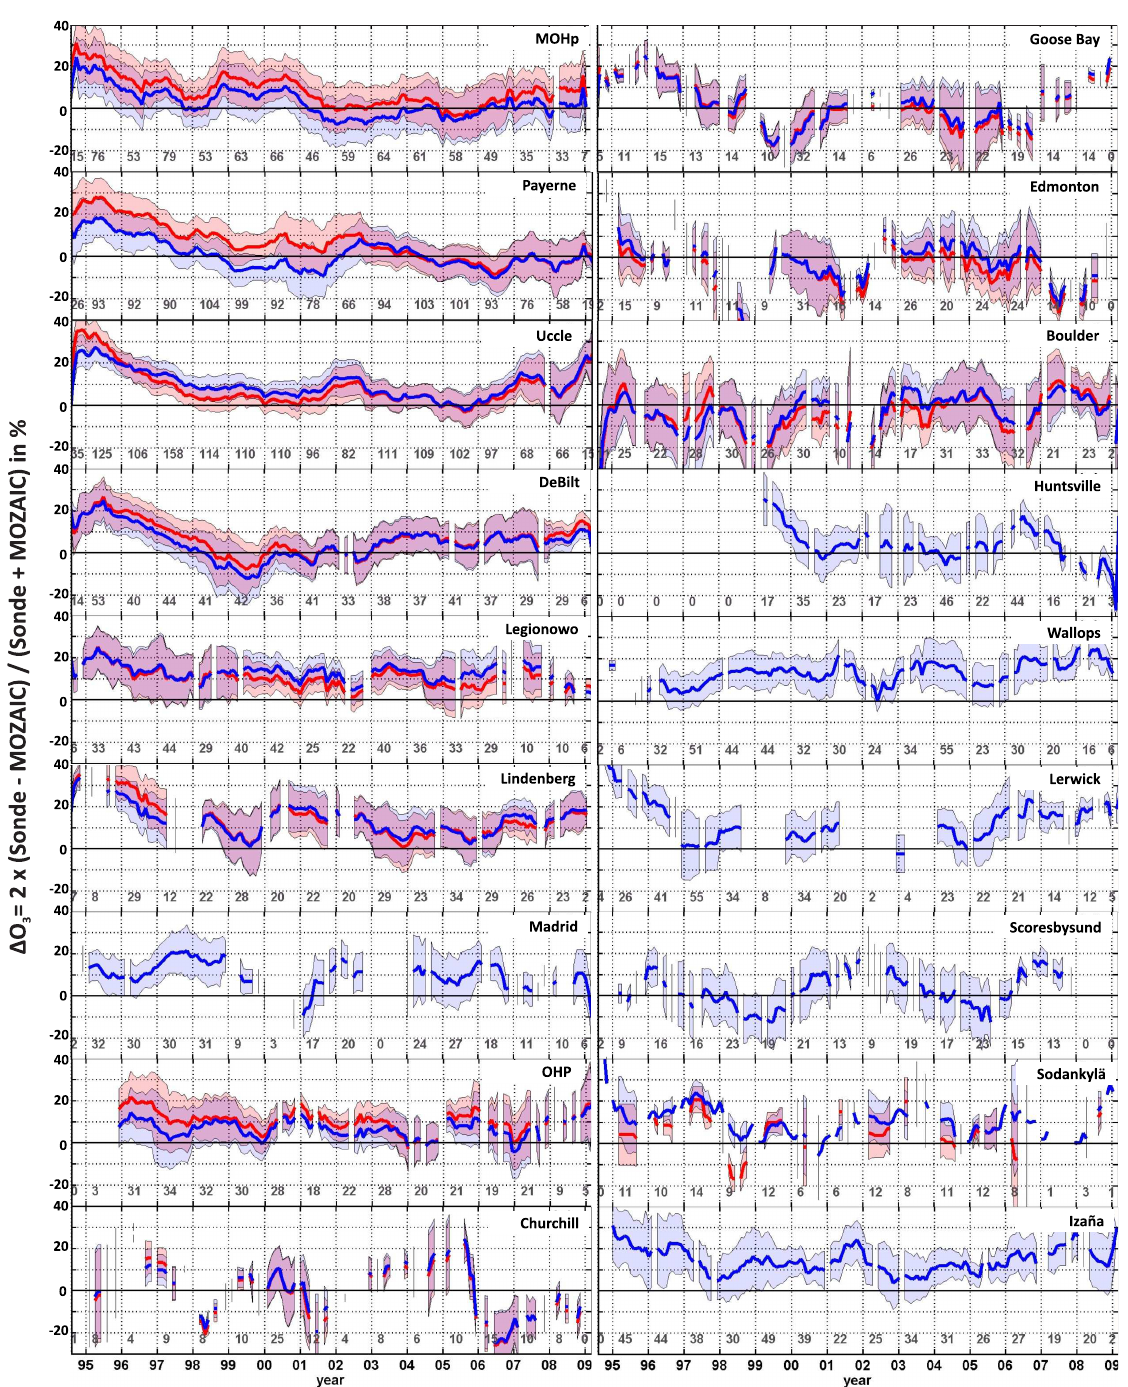
53 Fig. 16. Time series of the relative differences between ozonesondes and MOZAIC measurements ( 1 O 3 in %) in the upper troposphere. These time series comprise 20 of the 28 launch sites considered in this work (the 8 remaining have too few matches with MOZAIC to be included here). Note the large differences at nearly all sites from 1994 to 1998, and the systematic tendency for smaller differences at 10 of these stations thereafter, three using BM sondes (MOHp, Payerne, Uccle) and seven using SP or ES ECC sondes (De Bilt (SP), Legionowo (SP), Lindenberg (SP), Goose Bay (SP, ES), Edmonton (SP, ES), Lerwick (SP, ES), and Izaña(SP)). Bold lines: 1 O 3 time series with CF (red) and without CF (blue). Numbers at the bottom indicate the number of sondes used for calculating the monthly mean differences. The shaded areas denote the standard error (68% confidence). Overlapping areas are displayed in light